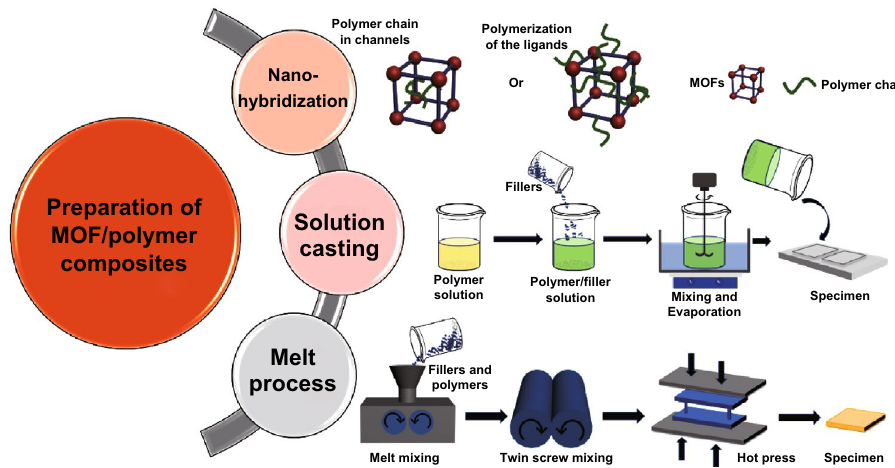
Fig. 4 Schematic of the possible methods for preparing polymer@MOF